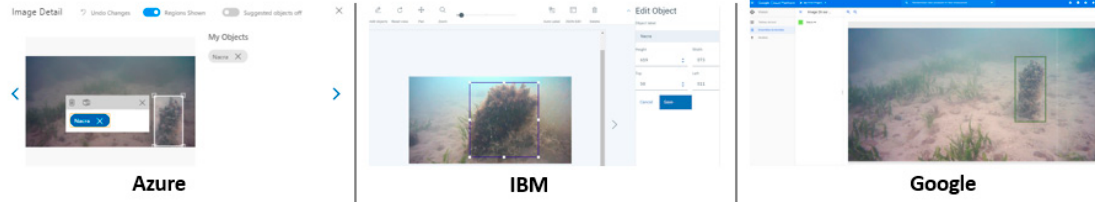
Figure5. Fanmusselrecognitiontraining: definingafanmusselboundingboxindi ff erentcloudservices. Figure 5. Fan mussel recognition training: defining a fan mussel bounding box in different cloud services.